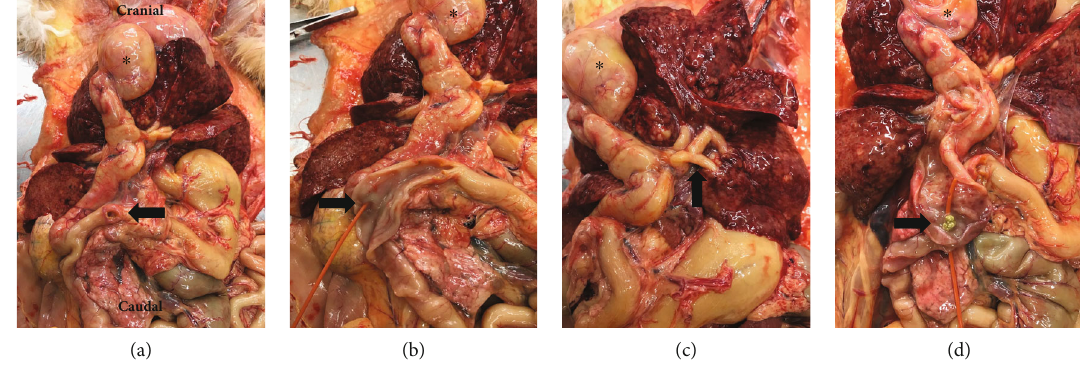
Figure 2: Necropsy images illustrating di ff use icterus, mottled liver, and severely dilated biliary system. Asterisk ( ∗ ) denotes the gallbladder in all images. (a) The arrow shows the full thickness duodenal ulceration. (b) The duodenum was opened, and a red rubber was passed through the major duodenal papilla (arrow) into the severely dilated common bile duct. (c) The arrow denotes the severely dilated hepatic ducts joining the cystic duct into the common bile duct. (d) The common bile duct was incised showing purulent discharge and a large stone lodged at the major duodenal papilla